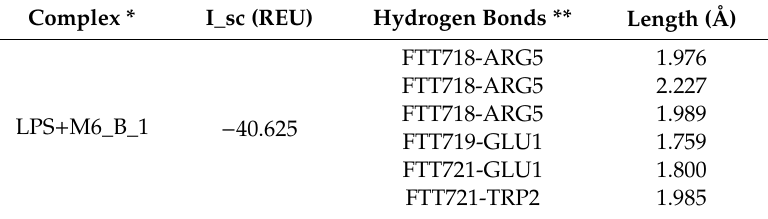
Table 5. Summary of the interface score and hydrogen bonds present in the refined complexes between Lipopolysaccharide (LPS)–FhuA and Ib-M6 peptide models.